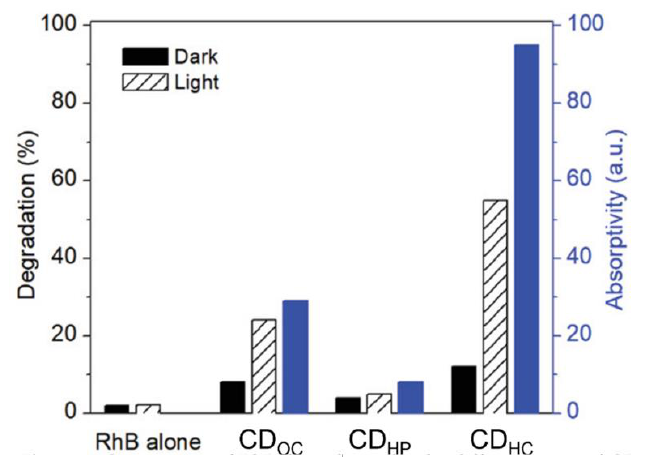
Figure 6. Comparison of RhB degradation by the different types of CDs under 6 hours of visible light irradiation and dark conditions. Reprinted with permission from [93] .